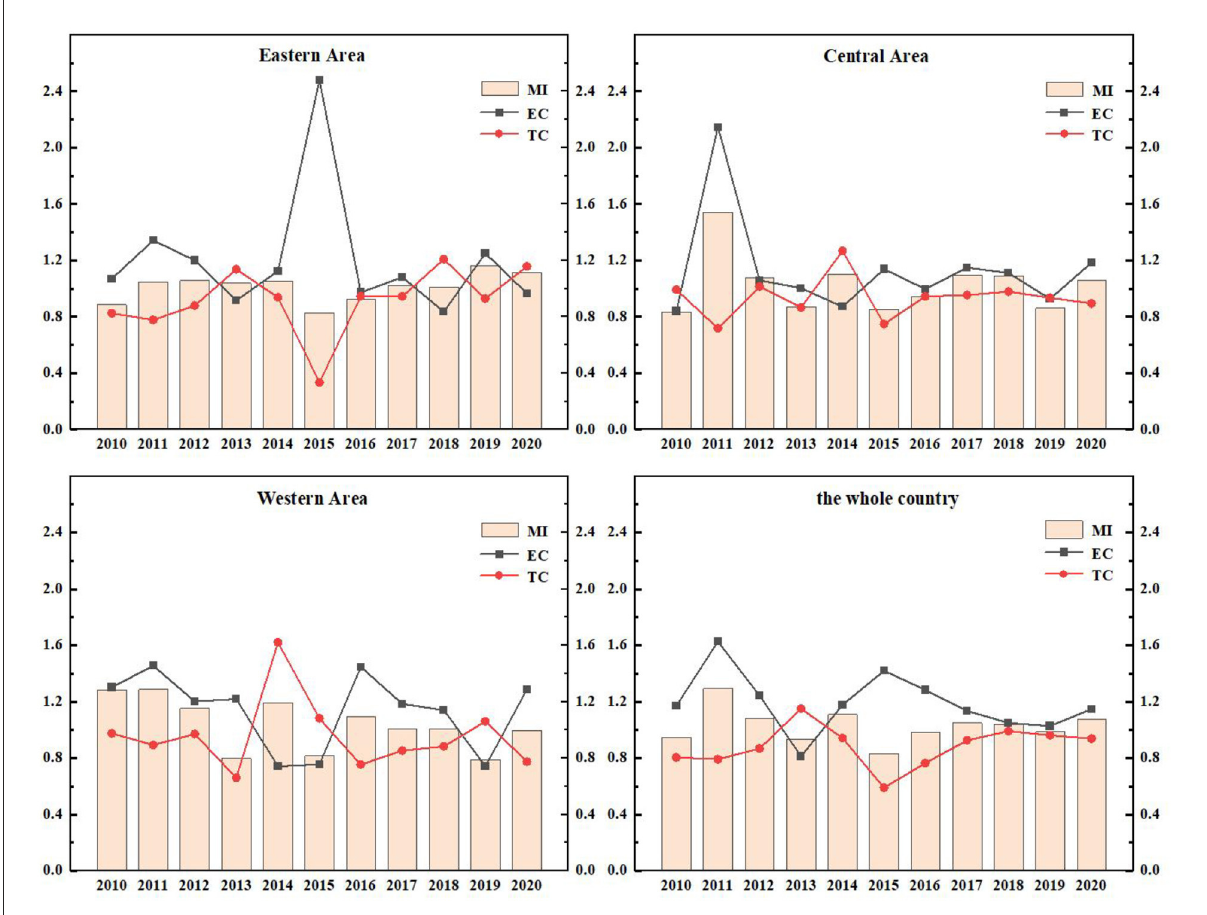
FIGURE3 ERDS and its decomposition index in Chinese different regions from 2010 to